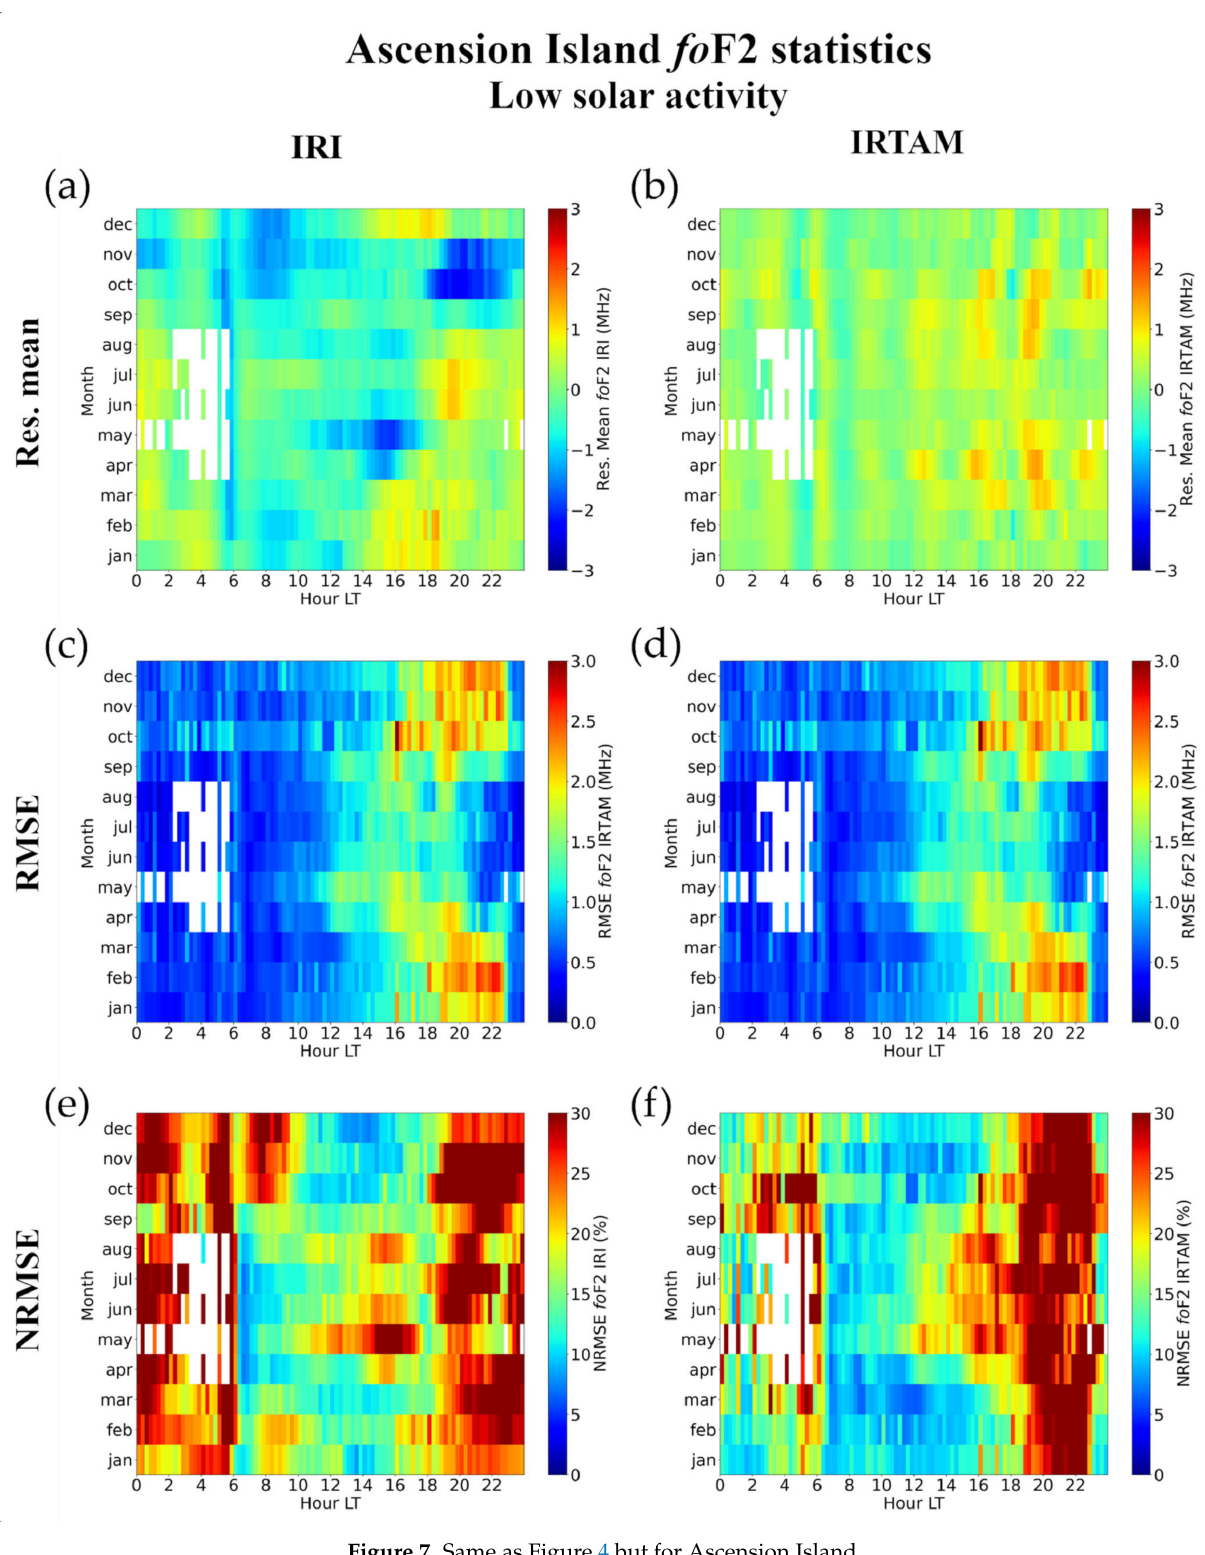
Figure 7. Same as Figure 4 but for Ascension